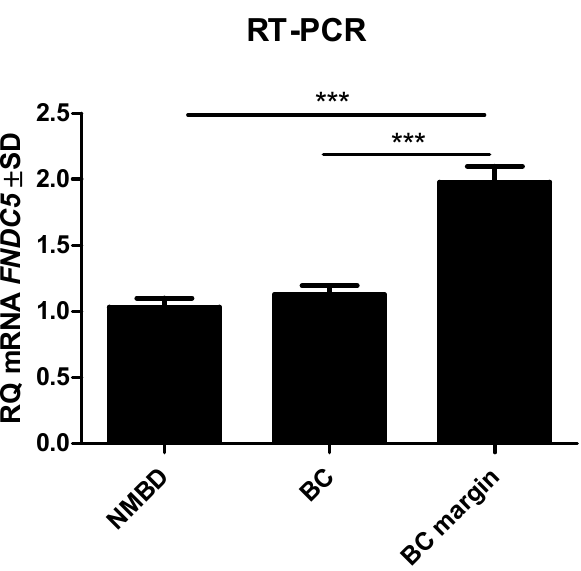
Figure 6. FNDC5 gene expression in NMBD samples, breast cancer (BC) cells, and BC tumor margin. *** p < 0.001.